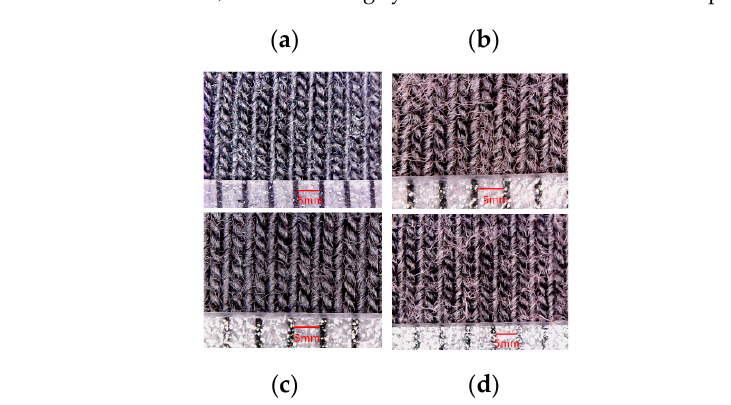
Figure 5. Variation of the ratio Ri/Ro vs washing cycles for PEDOT:PSS and silver-plated electrodes.